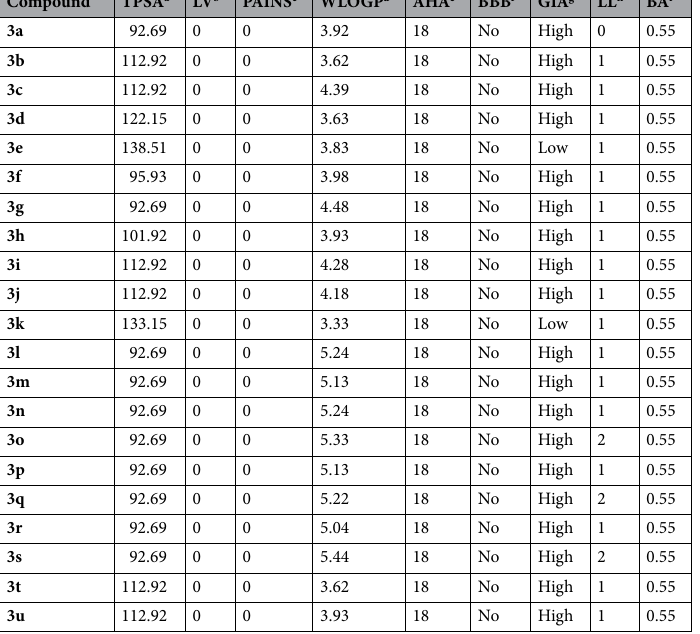
Table 1. In-silico ADME evaluation of synthesized compounds (3a-u). a Topological polar surface area, b Lipinski violations, c pan-assay interference, d logarithm of partition coefficient between n-octanol and water, e aromatic heavy atom, f blood brain barrier permeation, g gastrointestinal absorption, h lead likeness, i